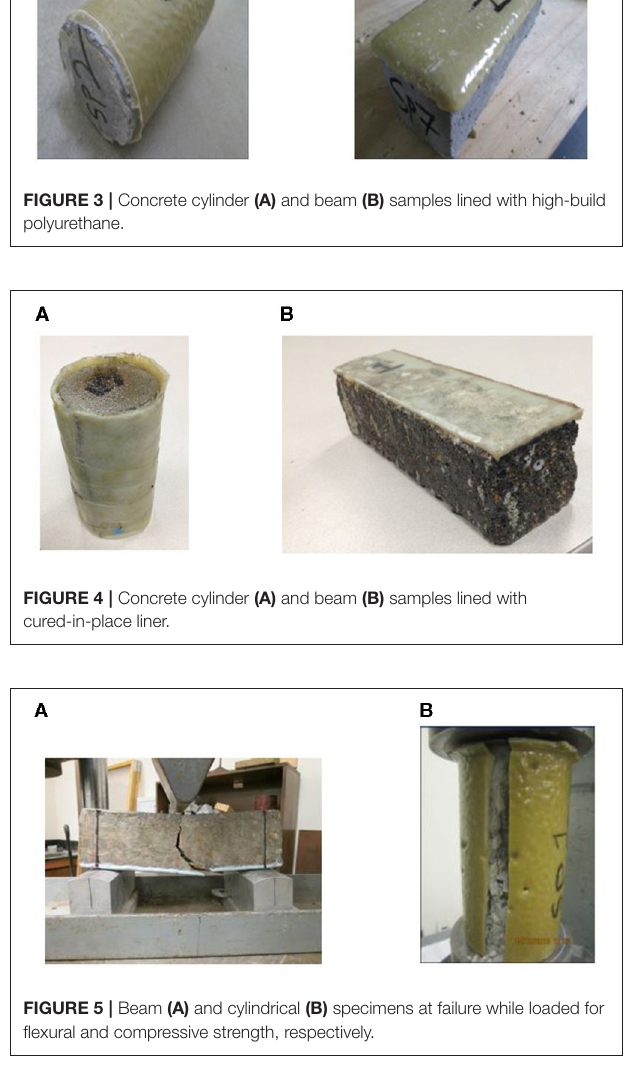
FIGURE 2 | Unlined (control) specimens prepared for the preliminary experiments.